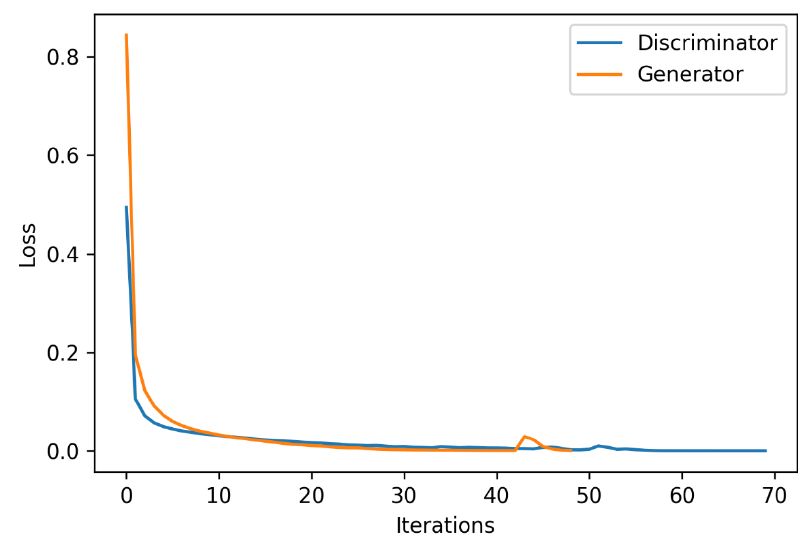
Figure 4. Loss of training of generator and discriminator model in CTGAN.